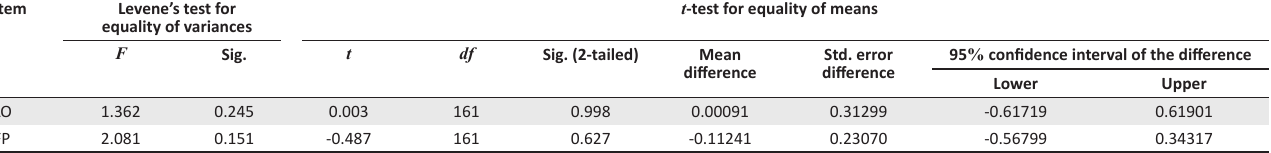
t -test for equality of